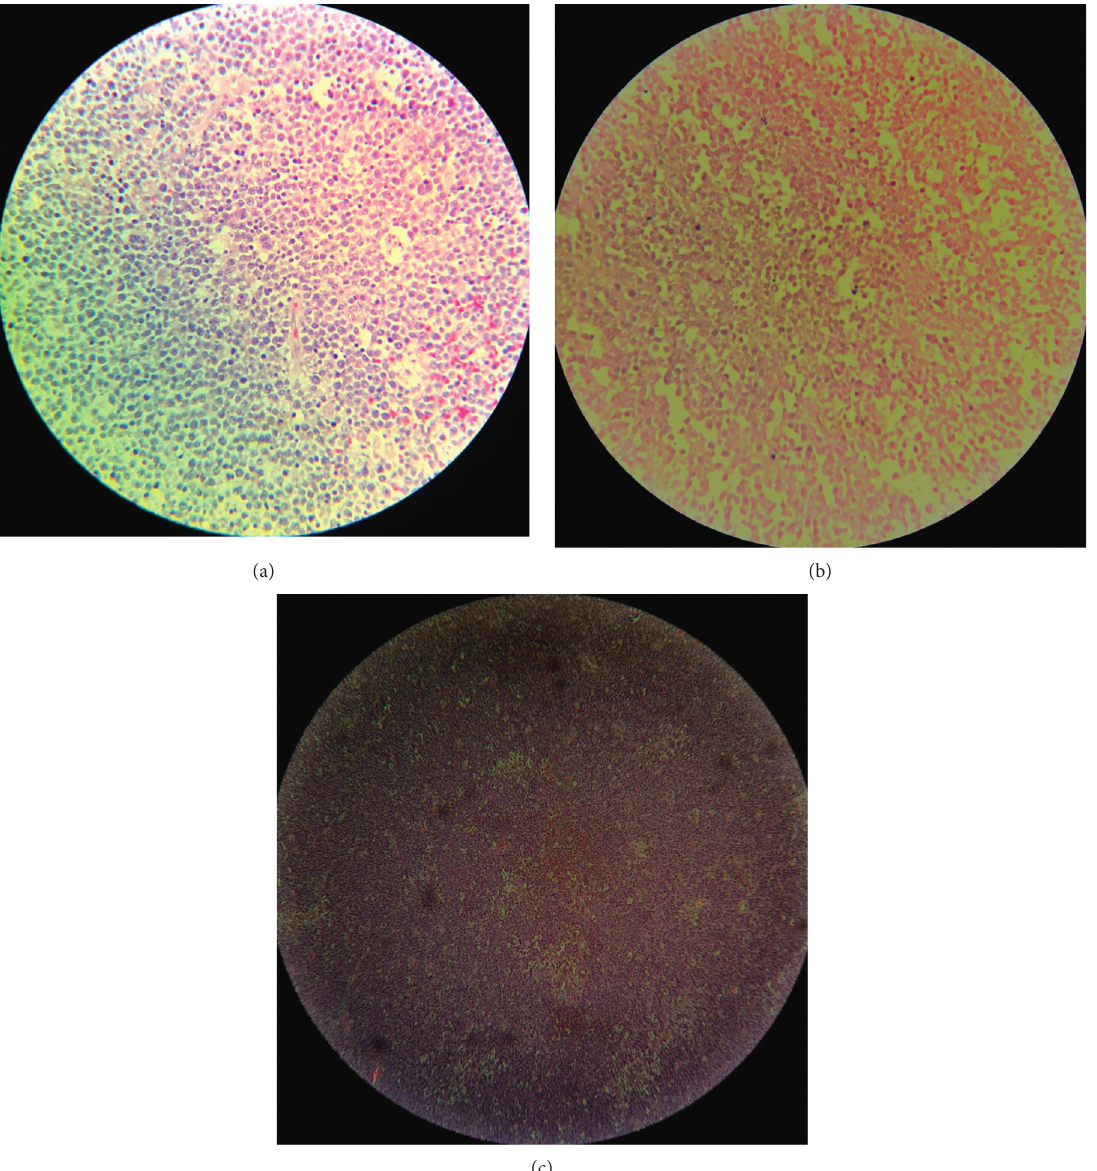
Figure 3: Histopathological examination of the appendectomy specimen. (a) Proliferation of poorly cohesive malignant lymphoid cells, composed of medium-sized to large nuclei, multiple prominent nucleoli, and scant cytoplasm. (b) Tumor cell necrosis. (c) Starry sky